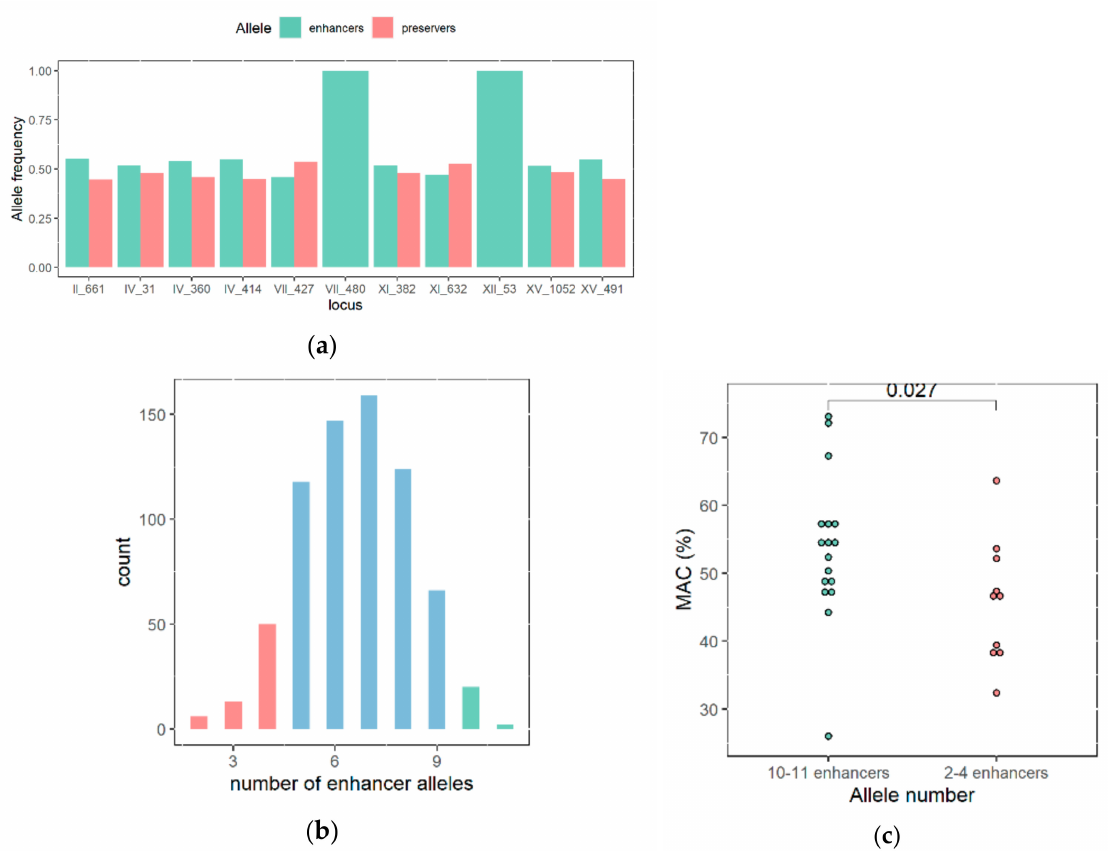
Figure 4. Marker assisted selection of FMGS-2 progeny for nine segregating alleles. ( a ) Allele frequency in the progeny, enhancer and preserver alleles are shown in green and red, respectively. ( b ) Distribution of the number enhancer alleles counted in the FMGS-2 progeny (797 fully genotyped progenies). ( c ) Phenotypic difference between progenies having enriched and minimized number of enhancer alleles; values indicated represented the average percentage of Malic acid Consumed (MAC) for each strain (3